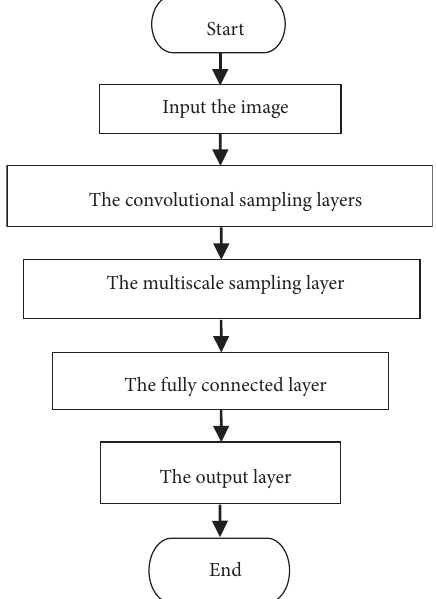
Figure 2: The MSDNN